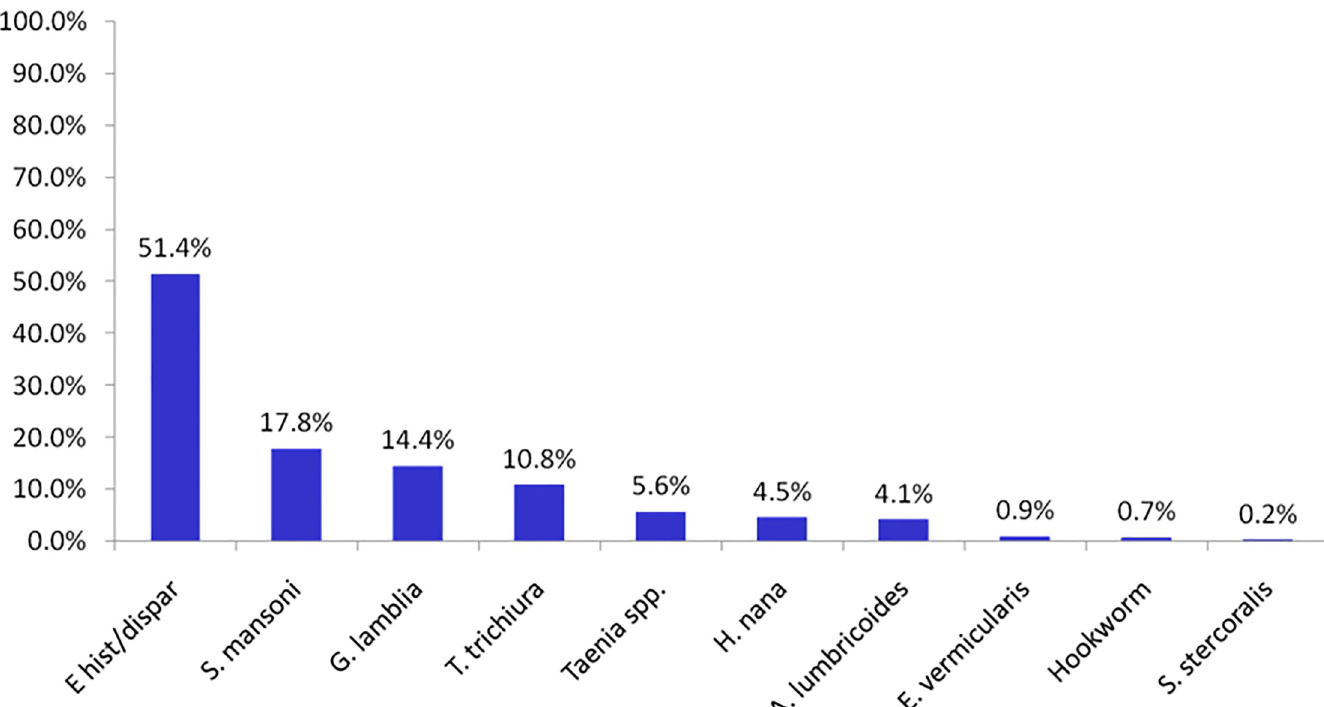
Fig 3. Frequency of intestinal parasites by parasite types among populations from three islands around Lake Ziway, Oromia Region, Ethiopia, 2013 (n = 323).